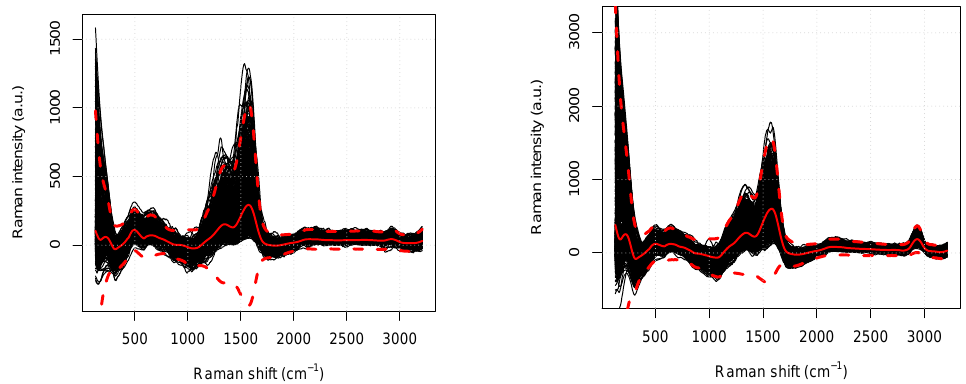
Figure 2. For the healthy ( left ) and tumoral ( right ) data set, we report the smoothed spectra (black solid lines), the average spectra (red solid lines), and the extreme curves computed by adding to and subtracting from the average Raman intensity three times the standard deviation (red dashed lines) labeling the decision